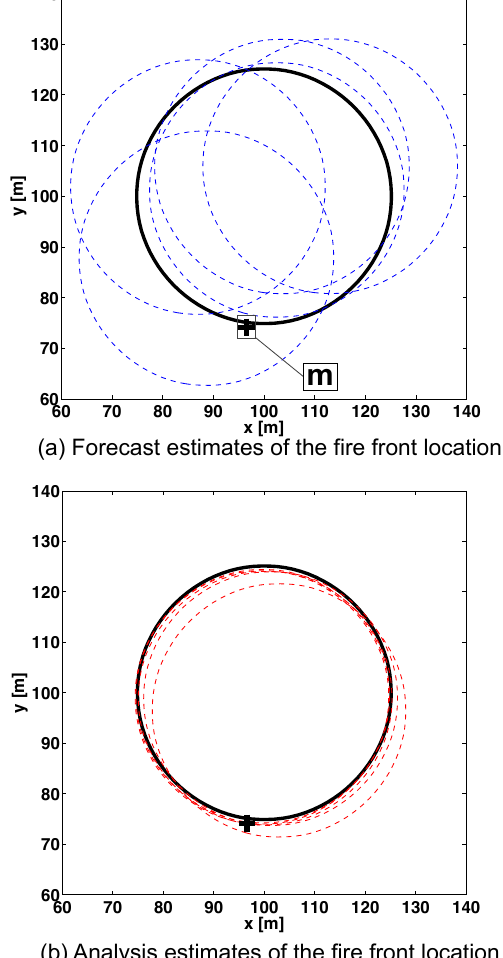
Figure 3. Spatially uniform OSSE test with constant ROS but un- certain ignition location ( x ign , y ign ); one assimilation cycle [0; 200s]; all figures correspond to the observation time t = 200s. (a) Comparison between true (black solid line) and forecast (blue dashed lines) fire front positions; the cross symbol is the only obser- vation available. (b) Similar comparison between true (black solid line) and analysis (red dashed lines) fire front positions.